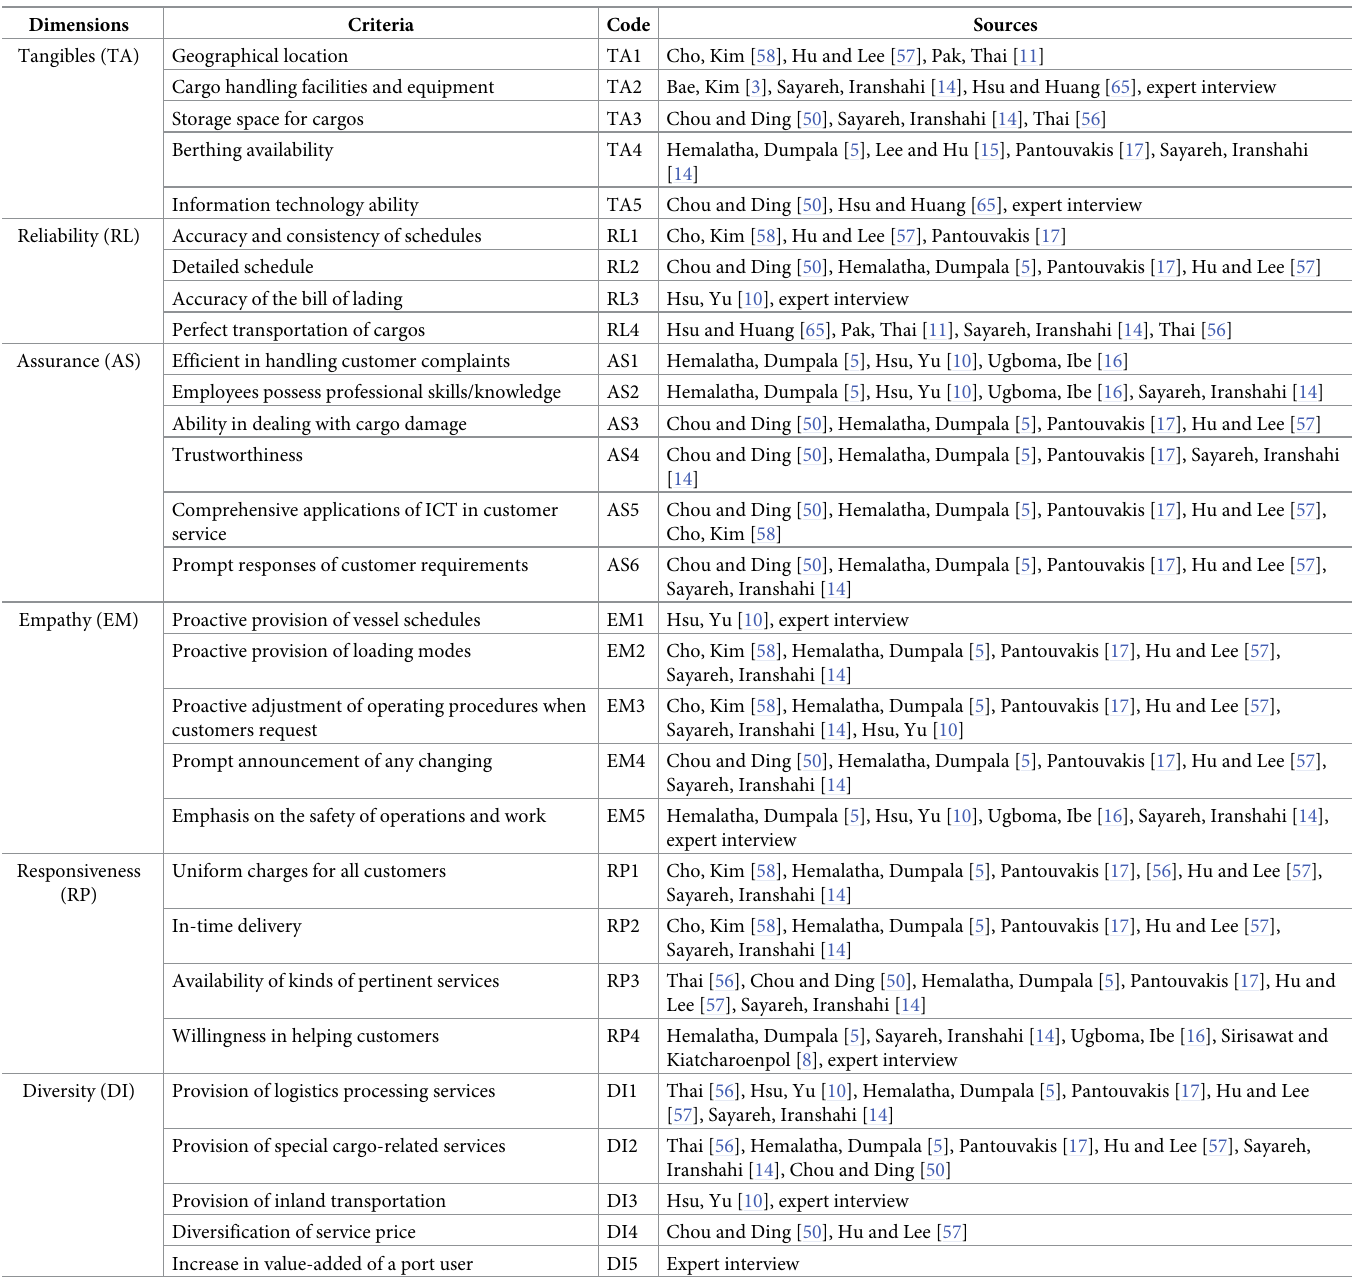
Table 2. The hierarchical structure of SAs. Dimensions Criteria Code Sources Tangibles